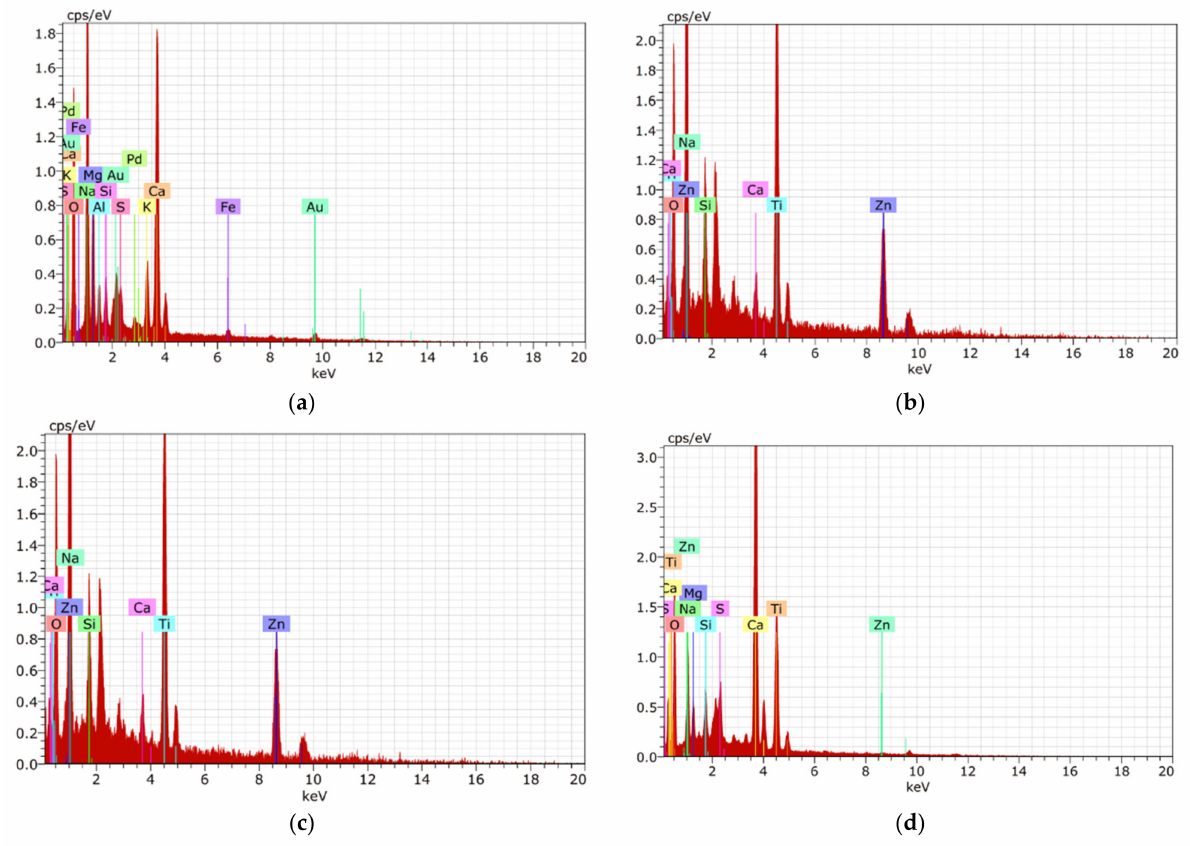
Figure 4. EDX spectra of TGA residue ( a ) unmodified, ( b ) modified before washing, ( c ) modified after 15 washings and ( d ) modified after 30 washings.